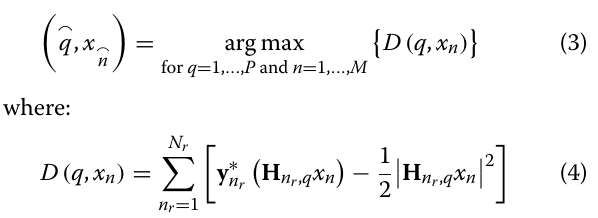
RecAnt-SSK constitutes a special case of RecAnt-SM, where the information bits are encoded only into the